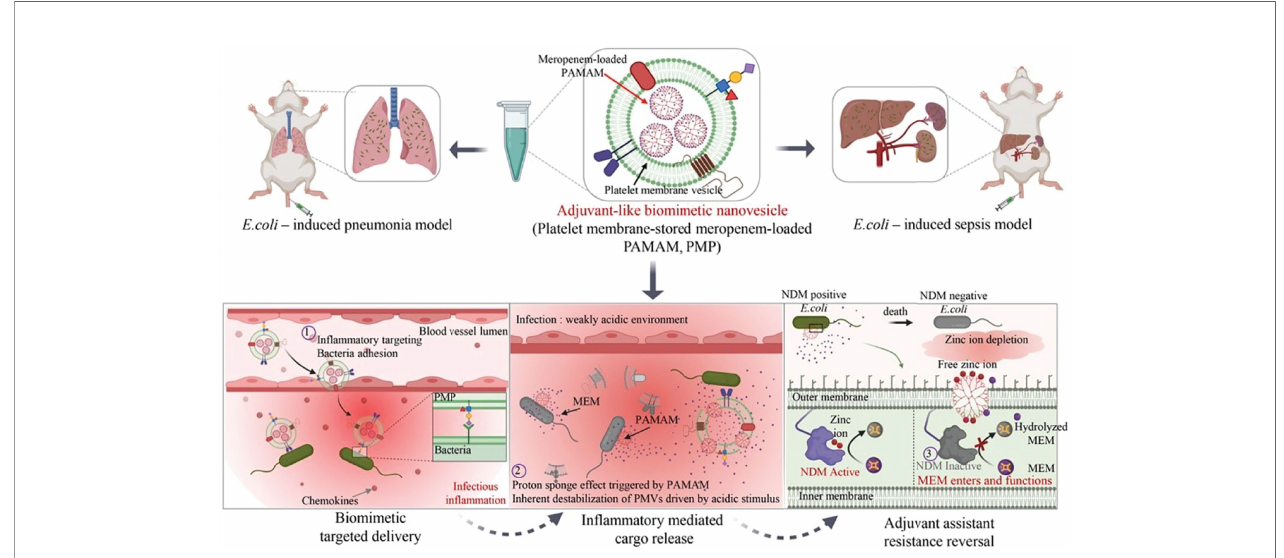
FIGURE 7 | Schematic illustration of adjuvant-like biomimetic nanovesicles could target the bacterial infection microenvironment and reverse carbapenem resistance for NDM-producing bacterial infections (142). Copyright 2021, Elsevier